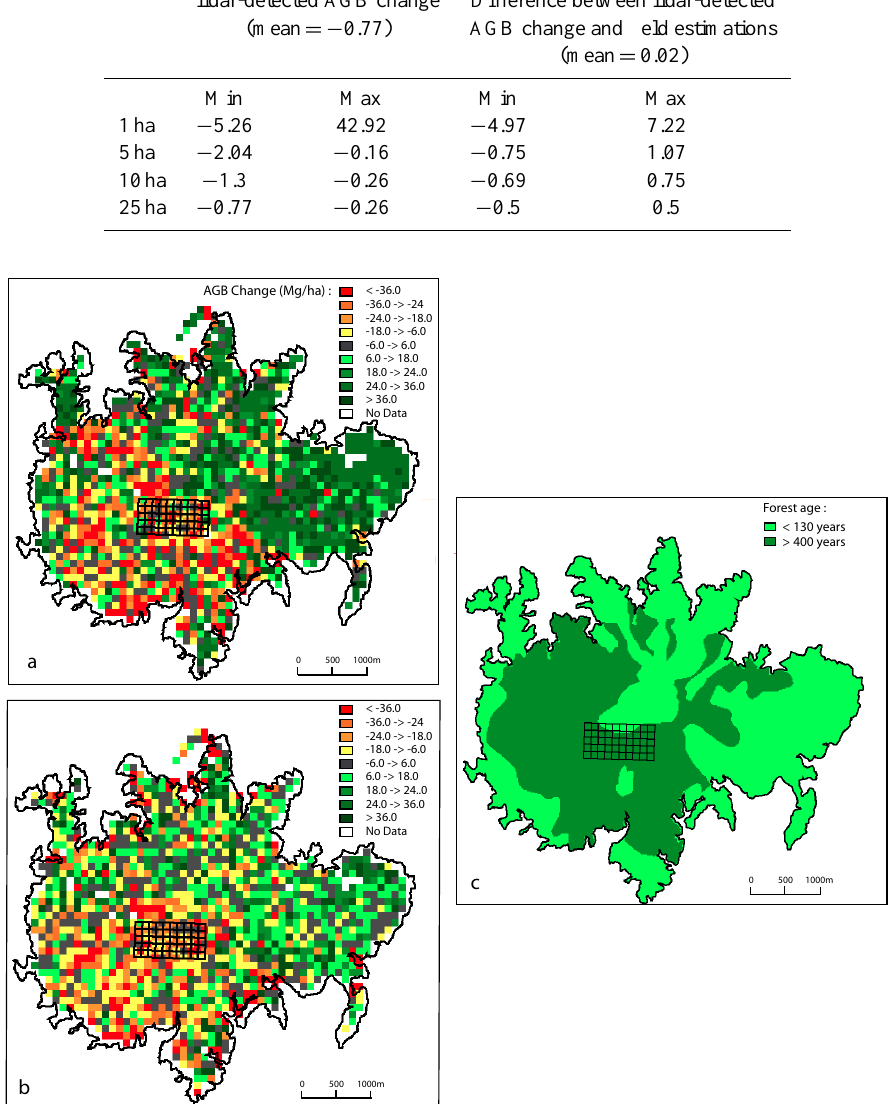
Fig. 8. AGB change maps between 2000 and 2010 ( a and b ) and forest age map (c) . The AGB change map from the 5RH approach (a) shows patterns of forest age more clearly than the AGB change map from the MCH approach (b) . Globally, AGB decreased in old growth forest (dark green in the age map), whereas the forest gained biomass in younger, regenerating forest (light green in the age map).